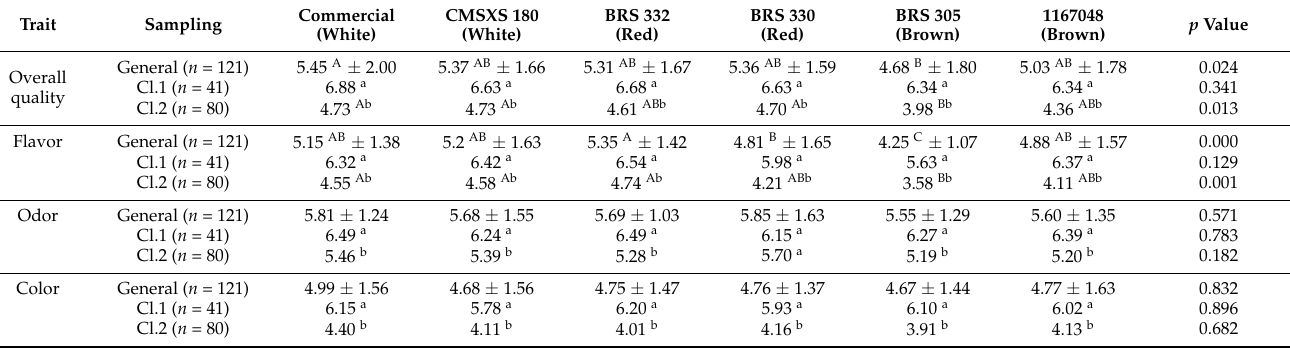
Table 4. Sensory acceptance of the six sorghum GFPa.